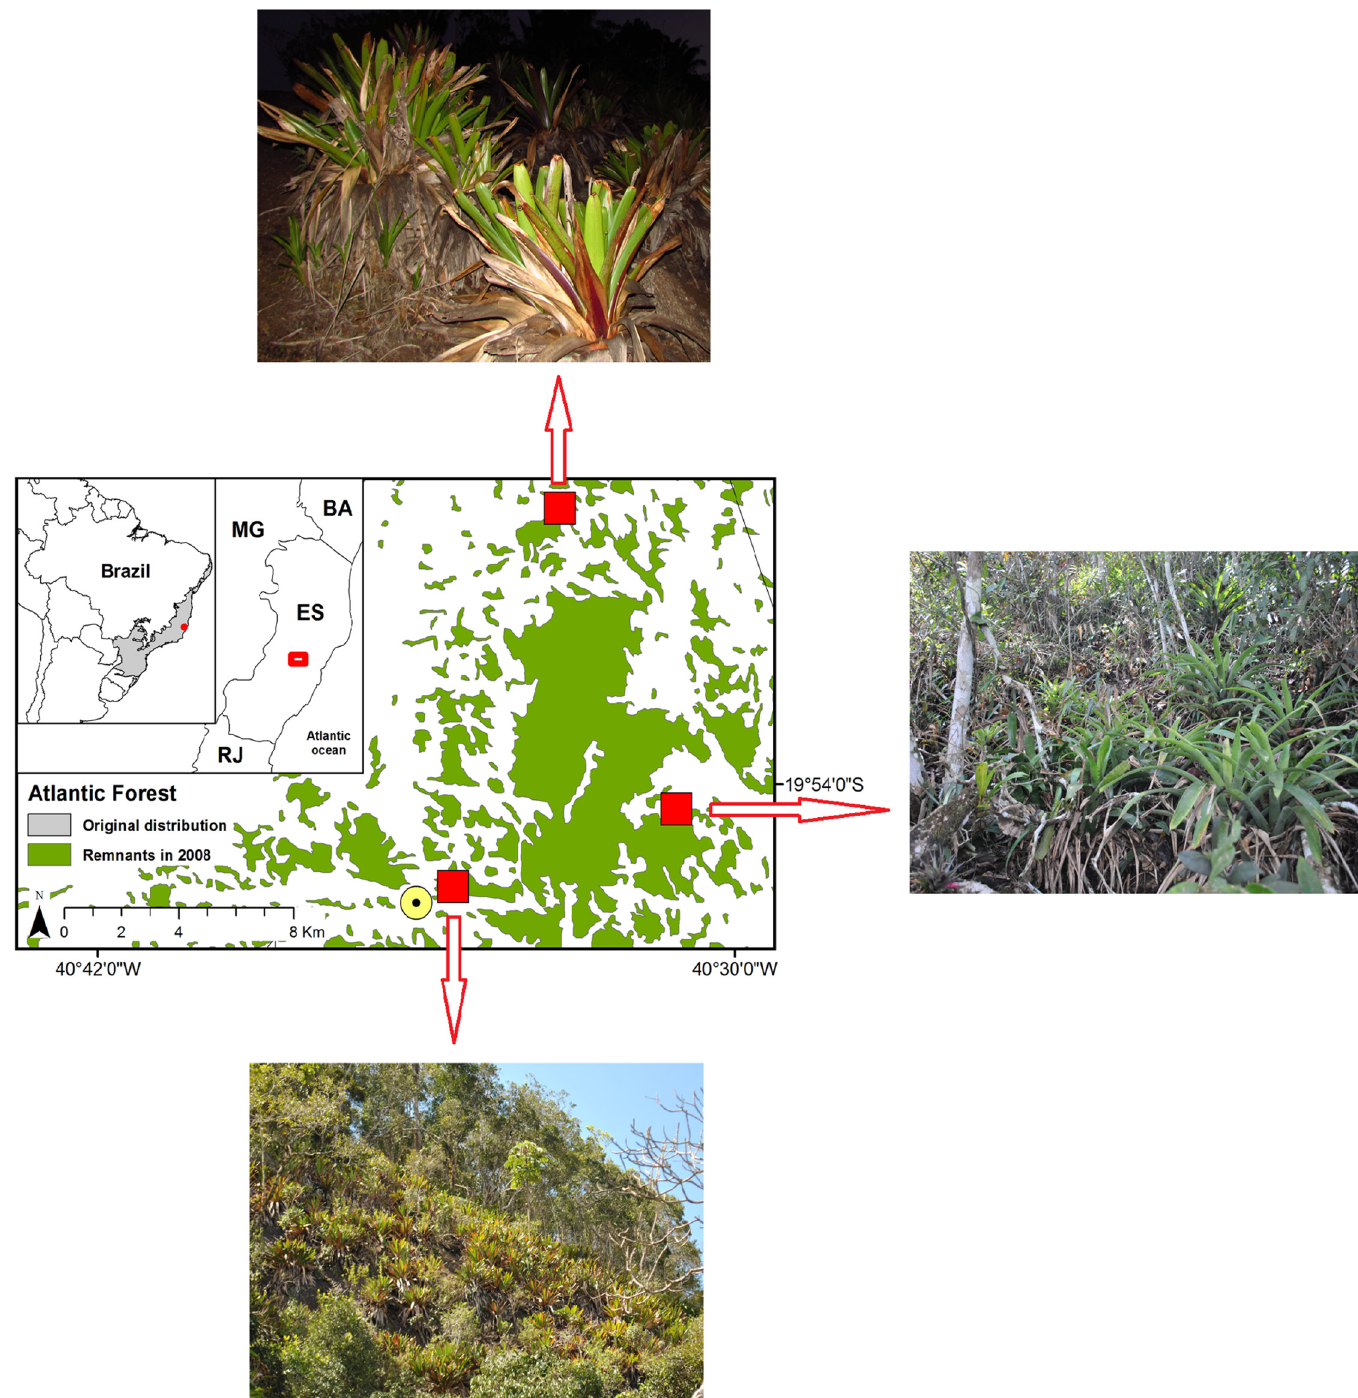
Fig 6. Geographic distribution of Dendropsophus bromeliaceus sp. nov.. Populations of the new species (red stars) and the city center of Municipality of Santa Teresa (yellow circle), southeastern Brazil. BA (State of Bahia), ES (State of Espírito Santo), MG (State of Minas Gerais), and RJ (State of Rio de